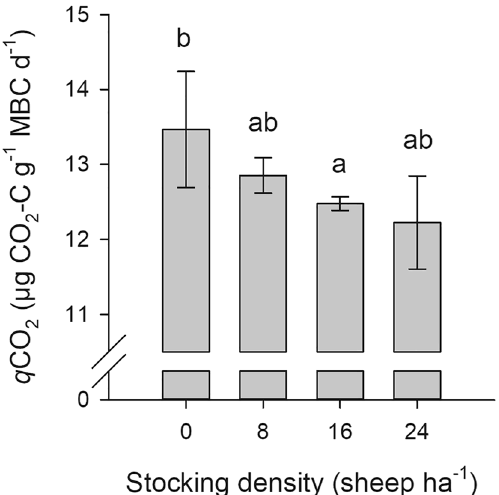
Figure 1. Mean metabolic quotient ( q CO 2 ) with standard error of means of a rangeland soil grazed by 0, 8, 16, and 24 sheep ha −1 in a two year grazing experiment from 2014–2015 on a summer pasture in the Chinese Altai Mountains, Qinghe, China. Data was transformed with an exponential function to obtain normal distribution of residuals. Letters indicate significant differences between treatment means (p < 0.05).